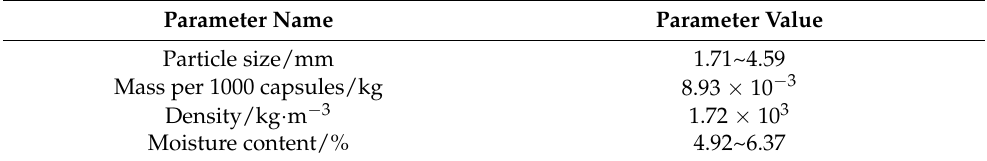
Table 2. Basic parameters of granular fungal fertilizer.